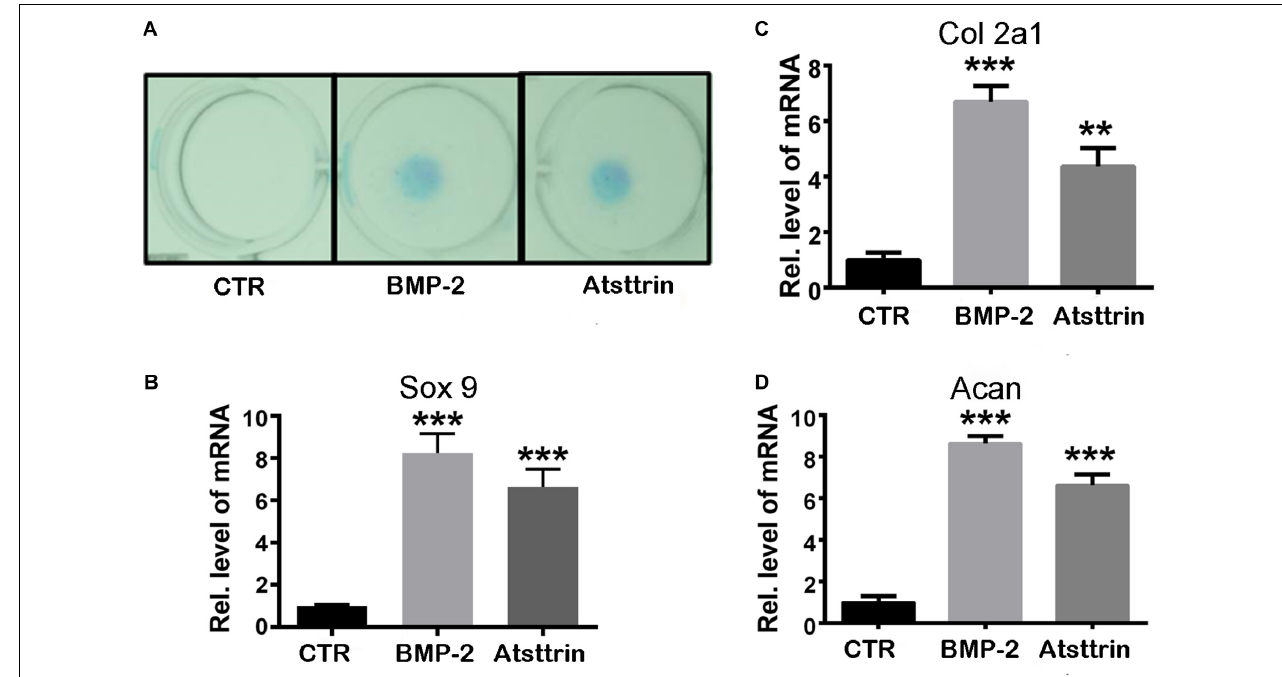
FIGURE 1 | Atsttrin promoted chondrogenesis in C3H10T1/2 cells. (A) C3H10T1/2 cells were incubated in the absence (CTR) or presence of 100 ng/mL BMP2 or 1000 ng/mL Atsttrin for 10 days, followed by Alcian blue staining. (B–D) C3H10T1/2 cells were stimulated with either 100 ng/mL BMP2 or 1000 ng/mL Atsttrin, and real-time PCR was performed to examine the expression of Sox9, collagen II (Col2a1), and aggrecan (Acan). Units were arbitrary; normalized values were calibrated against controls and set as 1. Experiments were conducted in triplicate. Three independent experiments were performed. *** P < 0.001, ** P <